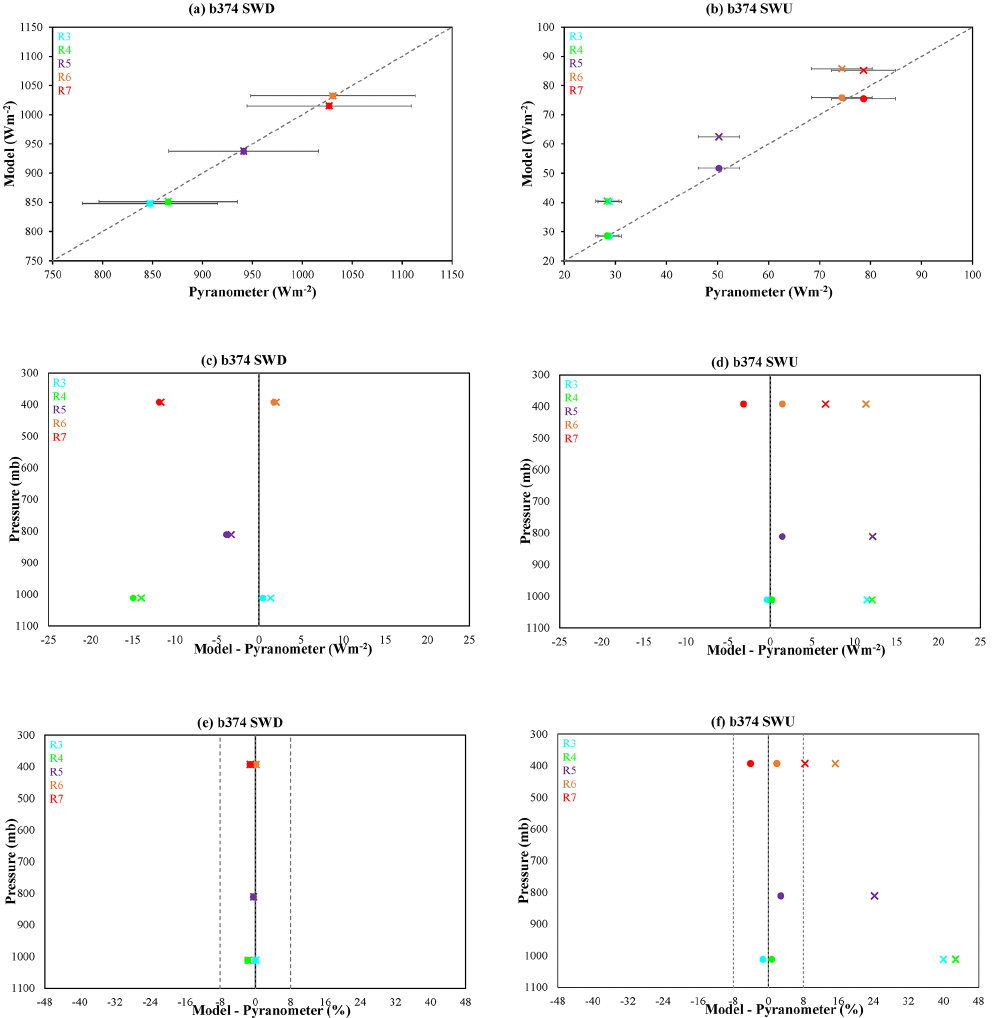
Figure 2. Comparison of modelled to measured irradiances for flight b374. (a, b) Scatter plots of modelled and measured shortwave down- welling (SWD) and upwelling (SWU) irradiances. Error bars show the maximum uncertainty of 8% in the pyranometer measurements (Haywood et al., 2001, 2003); (c, d) difference between measured and modelled irradiances as a function of the pressure at which the mea- surements were made; (e, f) percentage difference between measured and modelled irradiances as a function of the pressure at which the measurements were made. Dashed lines show percentage errors of less than 8%, representing the maximum uncertainty in the pyranometer measurements. Dots ( • ) show results obtained with values of the surface albedo from pyranometer measurements close to the surface, and crosses ( × ) results from the MERRA